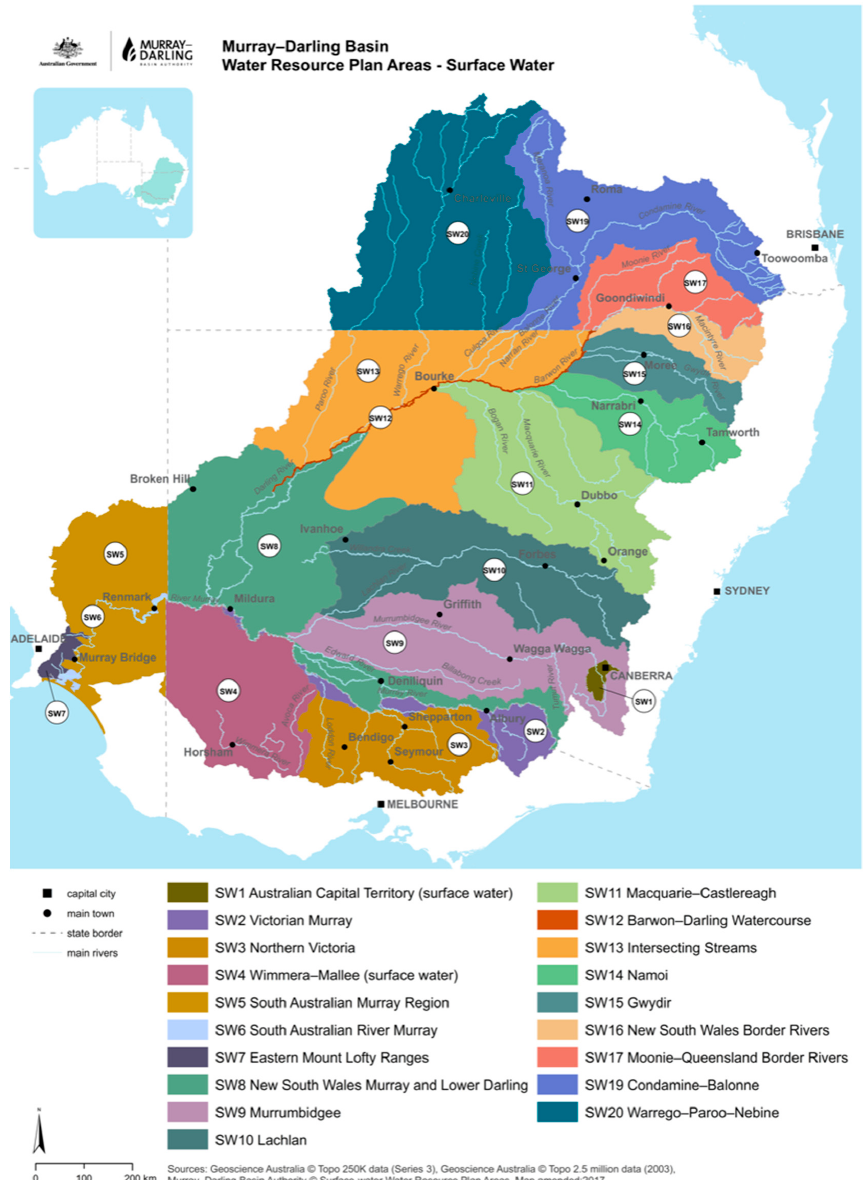
Figure 3. Surface water resource plan areas as defined by the MDB Plan [50].